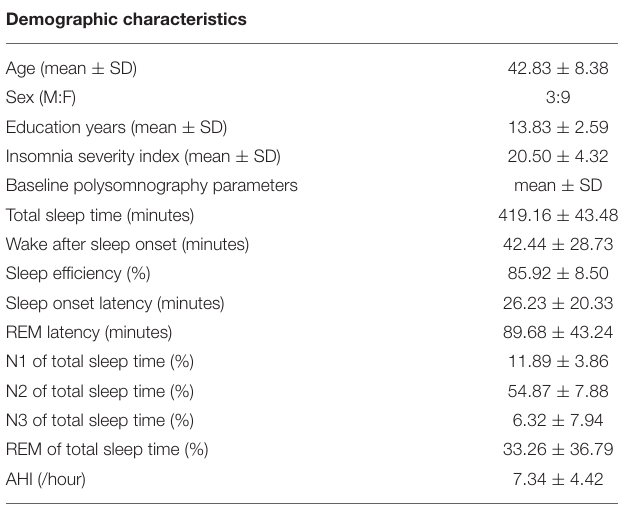
TABLE 1 | Demographic characteristics and baseline polysomnography (PSG) parameters of participants ( N =